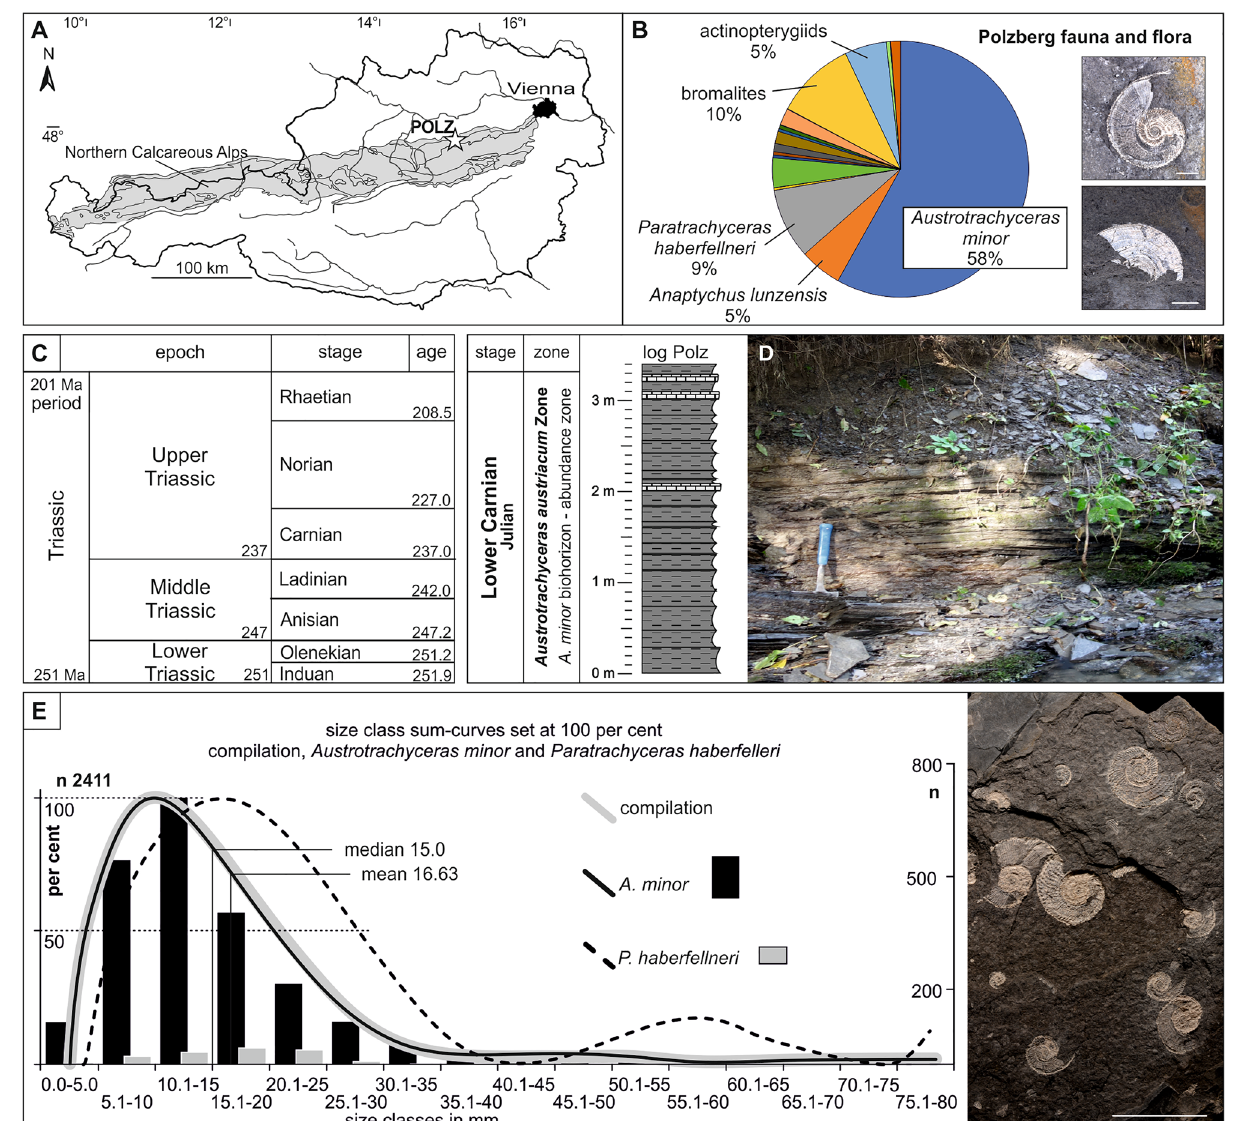
Figure 1. ( A ) Locality map of the Lunz area in Lower Austria and the Austrian Northern Calcareous Alps (in grey). Asterisk: position of the Konservat-Lagerstätte Polzberg (POLZ). ( B ) Pie chart of the Polzberg fauna and flora, indicated with dominant faunal elements, scale bars 1 cm. Images of specimens by AL. ( C ) Stratigraphic position of the Lower Carnian Polzberg palaeobiota. ( D ) with indicated detail of the section within the Carnian Reingraben Shales in the ravine Polzberggraben, 16 September 2021, by PL. ( E ) Compilation of size classes from n 2411 specimens of the genera Austrotrachyceras and Paratrachyceras and their species A. minor and P. haberfellneri with indicated example of ammonoid ontogenetic stages, image of specimens by AL, ammonoid layer in (E) NHMW 2021/0123/0139. Prepared by AL using CorelDRAW X7; www. corel draw.